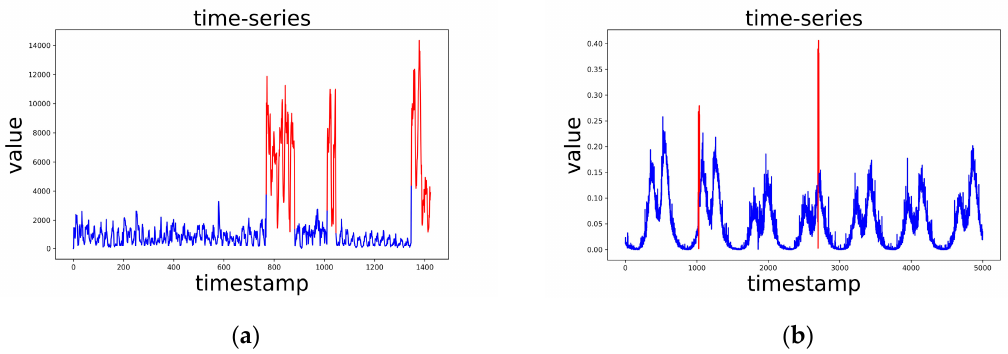
Figure 1. Time series used in our experiment, and the red parts are anomalies. ( a ) An example from Yahoo dataset. ( b ) Time series in KPI